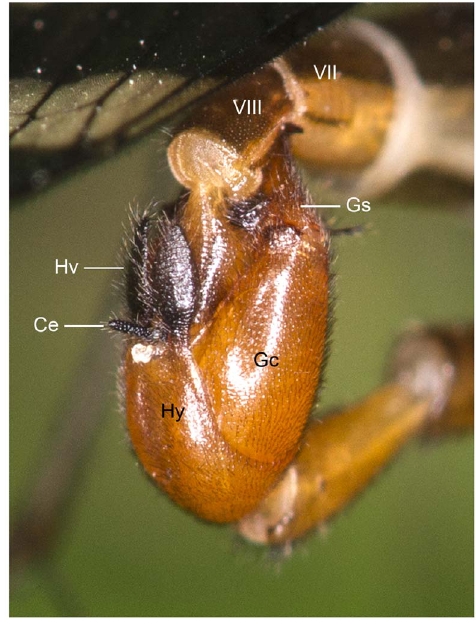
Figure 2. Genitalia of N.longiprocessa in copula, with the female at the up and the male at the bottom. Ce, cercus; Gc, gonocoxite; Gs, gonostylus; Hv, hypovalve; Hy, hypandrium.